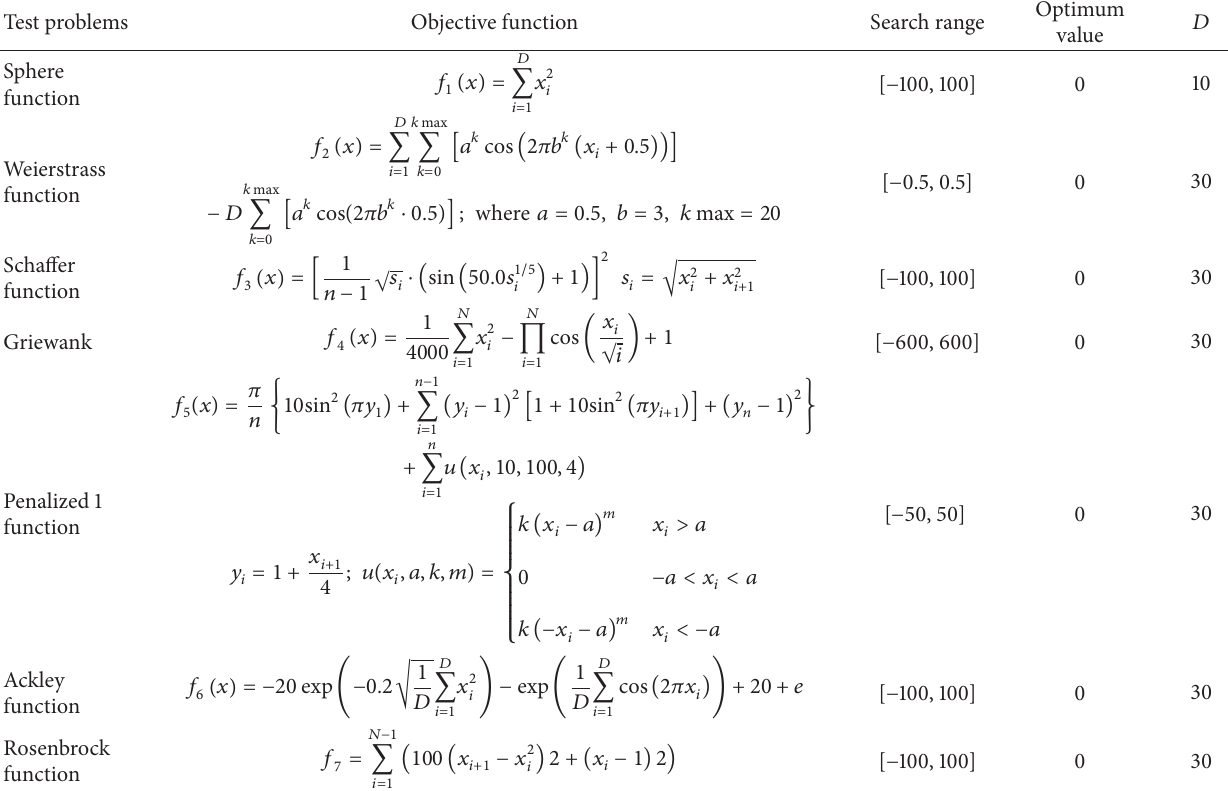
Table 1: Description of test